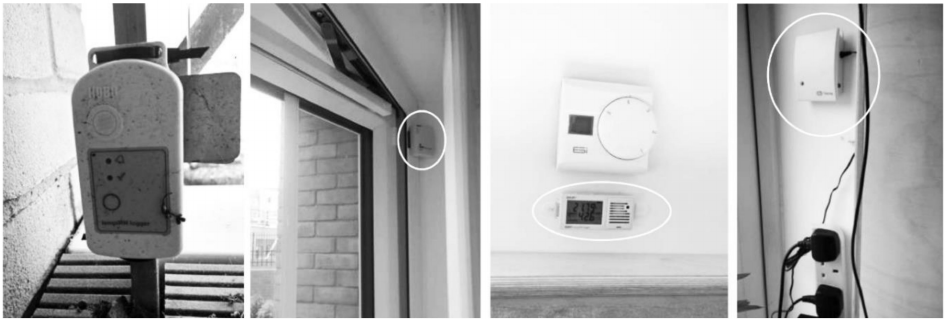
Figure 4. Environmental monitoring devices installed in the flats. From left: Outdoor temperature and RH logger, window state logger, interior temperature and RH logger and CO 2